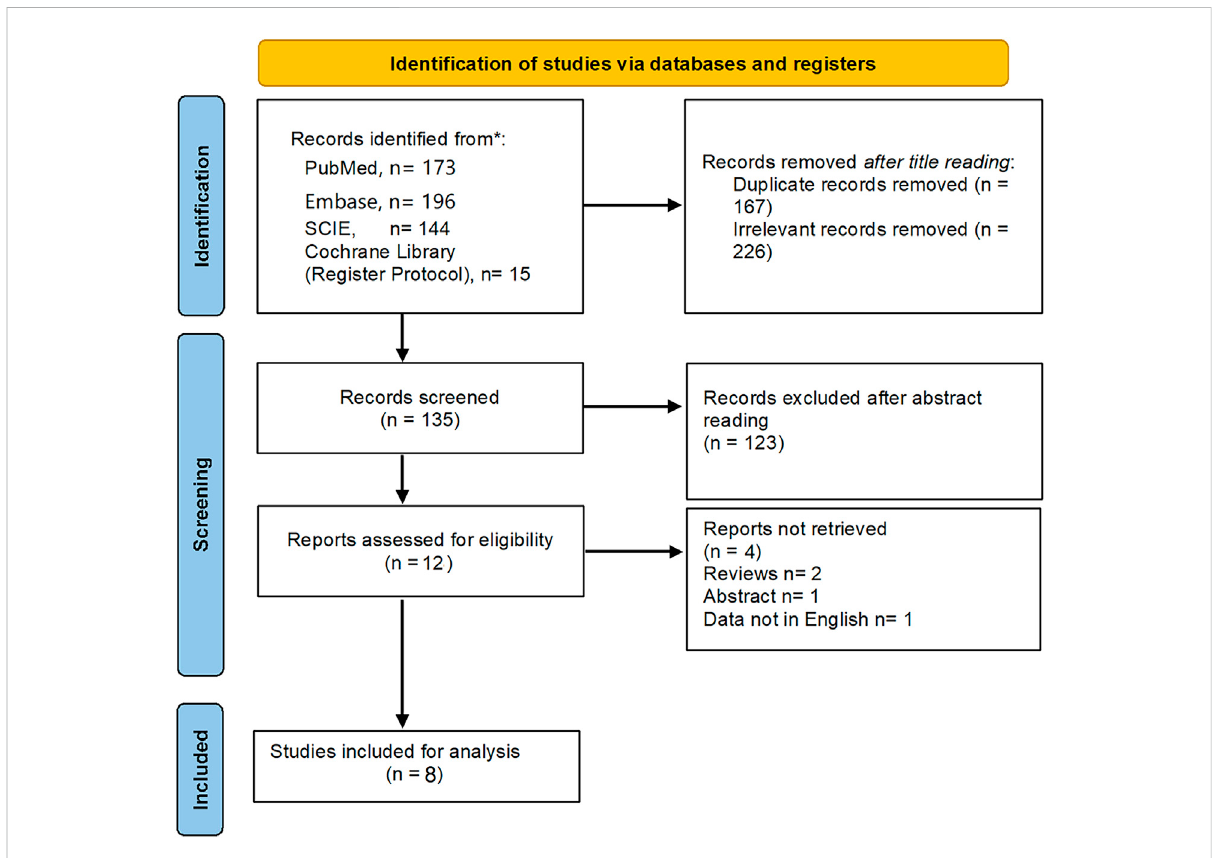
FIGURE 1 The fl owchart of study